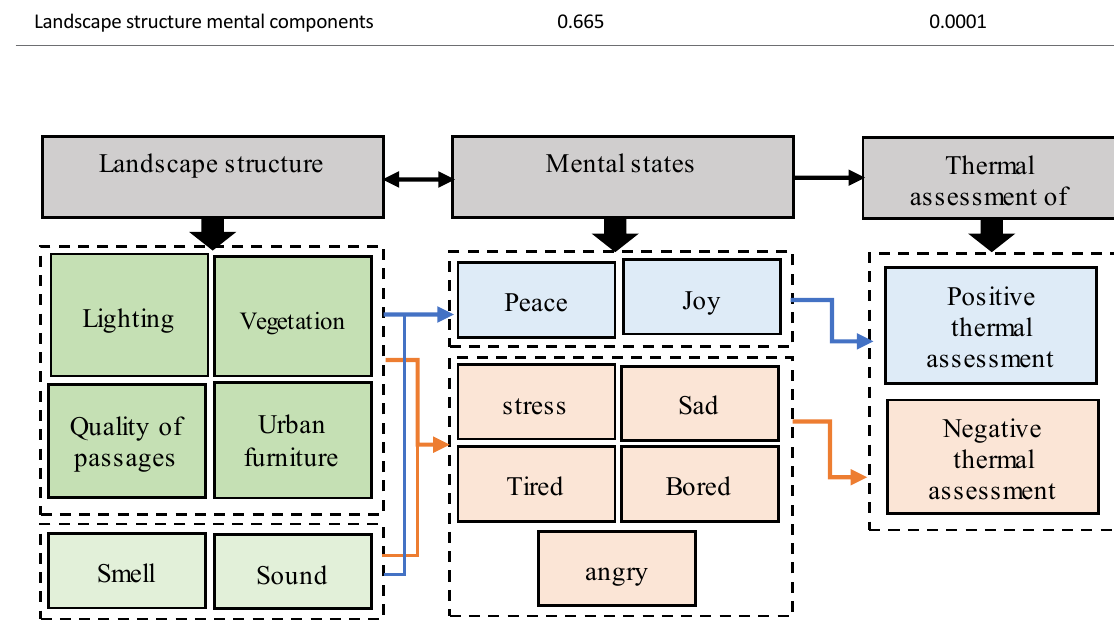
Significance Level Correlation CoefficientModel